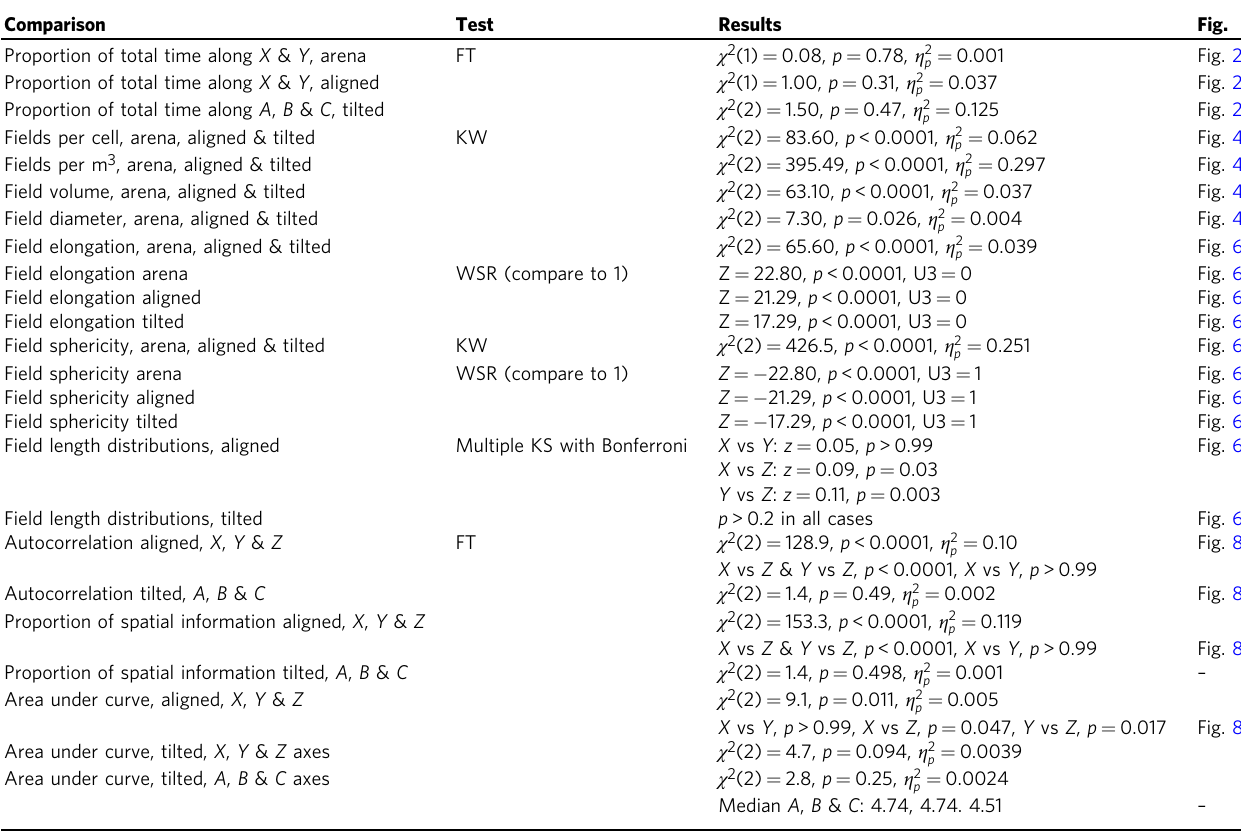
Fig. 10, Supplementary Data: Comparison of fi ring properties between mazes